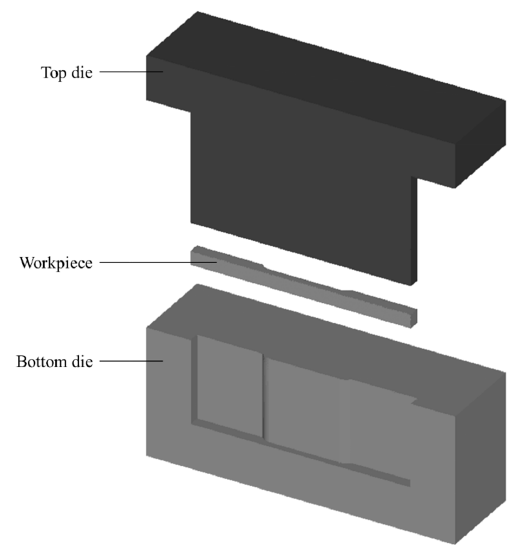
Figure 1. Hot press forging simulation part features drawn from AutoCAD. Table 1. MMC–Al R material properties.